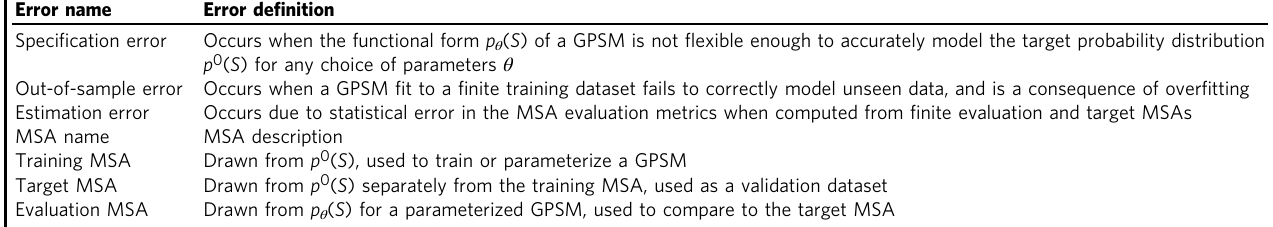
Table 1 Glossary of error types, and the MSA datasets we use to evaluate these